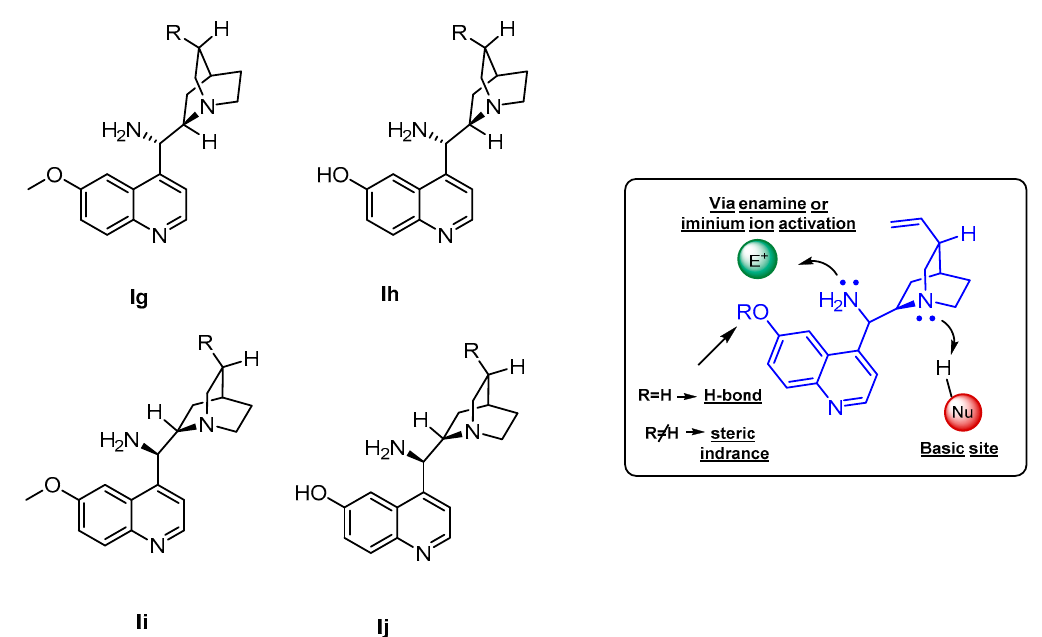
Figure 5. Cinchona alkaloids derivatives functionalized at the C9 position.